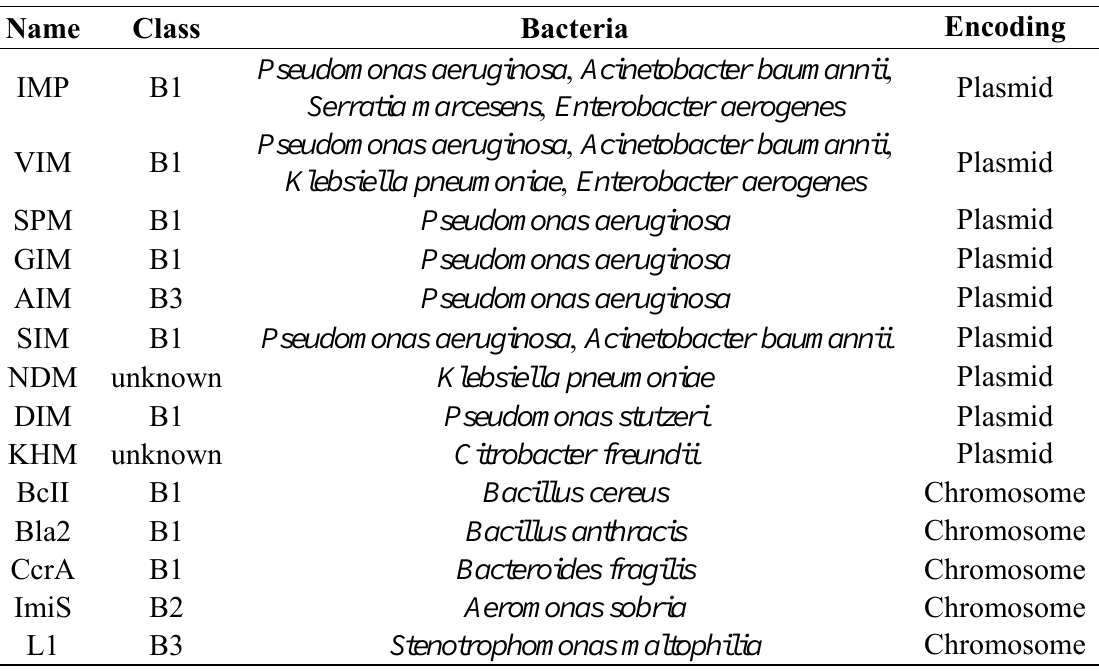
Table 1. Description of most common plasmid- and chromosome-mediated MBLs, their classification, and the bacteria in which they are